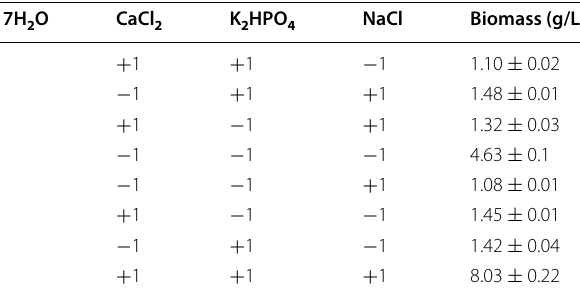
tional file 1: Table S1 and S3 show the high and low lev- els of each factor used in the Plackett–Burman design experiment.